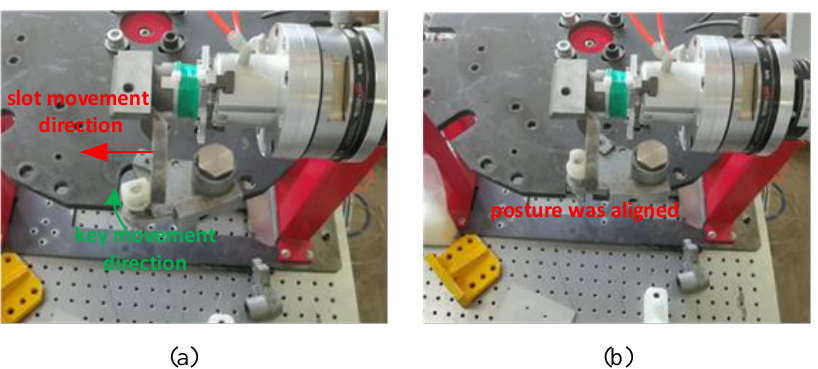
Figure 13. Alignment the key-shaft component. ( a ) the initial error of the key-shaft component; ( b ) Result of the error compensation;